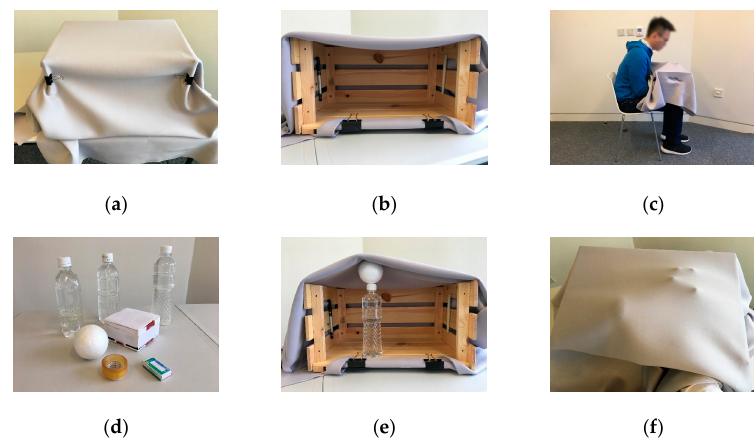
Figure 1. The appearance of ClothSurface. ( a ) View from the outside. ( b ) Opened side of the box. ( c ) ClothSurface in use. ( d ) Everyday objects provided. ( e ) Water bottle used as a support to free up designer’s hands. ( f ) View from the outside.